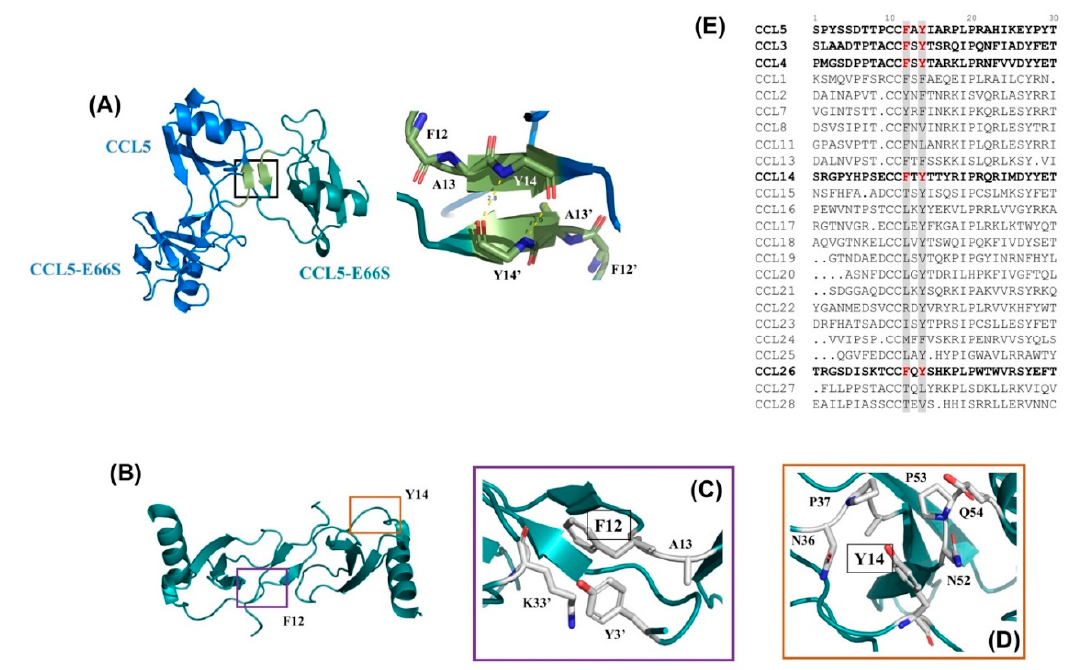
Figure 9. Structure of the CCL5 trimer formation and the interactions of F12 and Y14. ( A ) Overall structure of the CCL5 trimer structure with two CCL5-E66S molecules in complex with one native CCL5 molecule (PDB code 6AEZ). The interface between CCL5-E66S and CCL5 responsible for CCL5 aggregation. ( B ) The locations of F12 and Y14 on the CCL5 dimer (PDBtable code 1EQT). ( C ) A close-up view of the residues near F12. Residue F12 provides intermolecular interactions to stabilize dimer assembly. ( D ) A close-up view of the residues near Y14. Residue Y14 provides hydrophobic interactions with neighboring residues. ( E ) Sequence alignment of the CC-type chemokines for the first 30 residues.